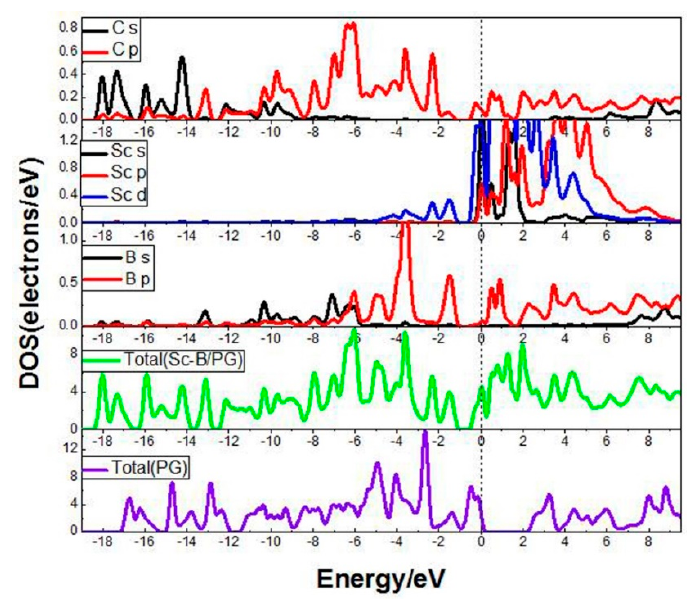
/ PG system and PG Figure 3. DOS of the Sc-B/PG system and PG system. Figure 3. DOS of the Sc-B